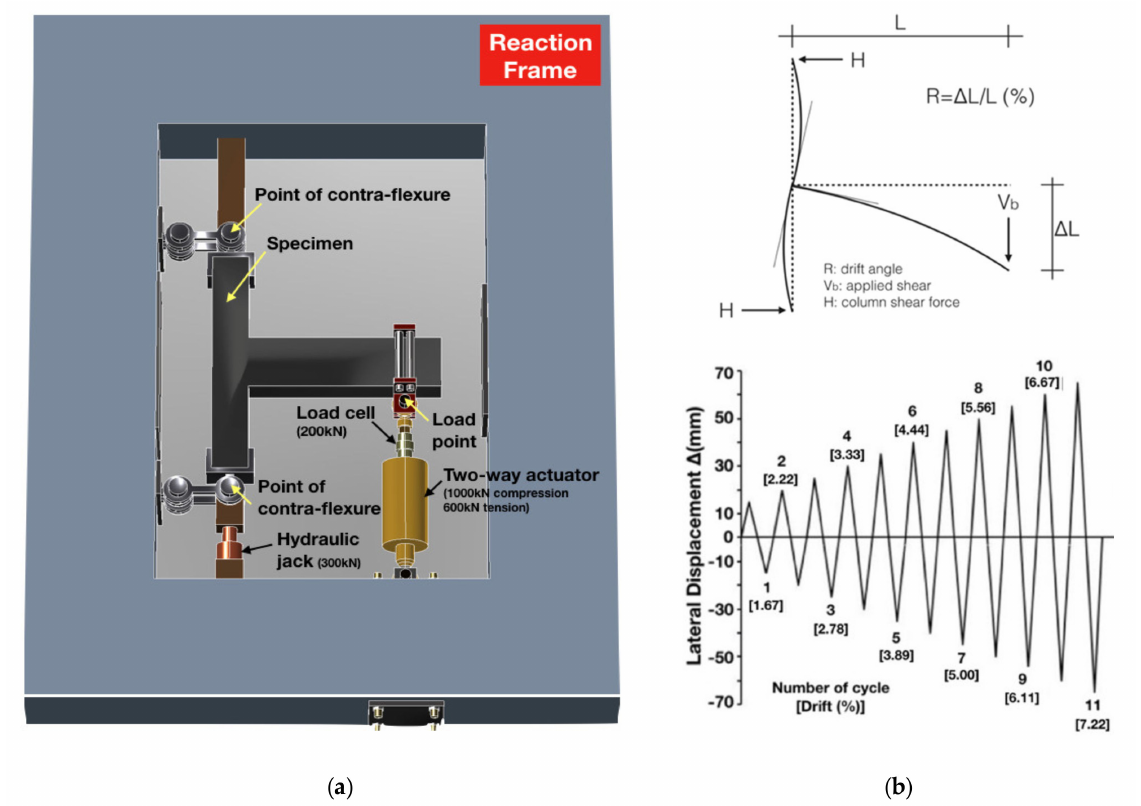
Figure 2. ( a ) Aerial view of the test setup and instrumentation used; ( b ) qualitative deformed shape of the specimens and lateral displacement